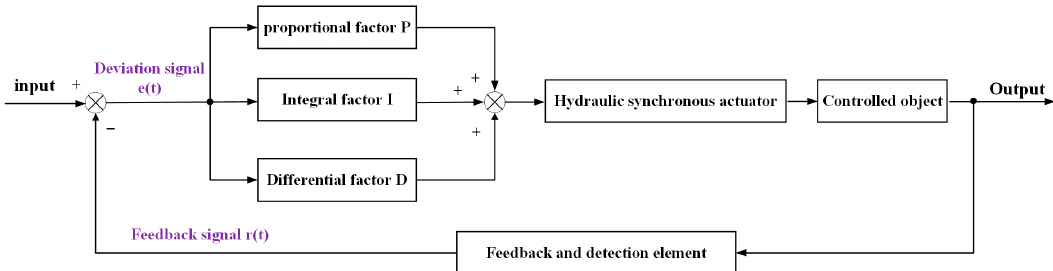
Figure 10. PID control block diagram of hydraulic synchronization control system.